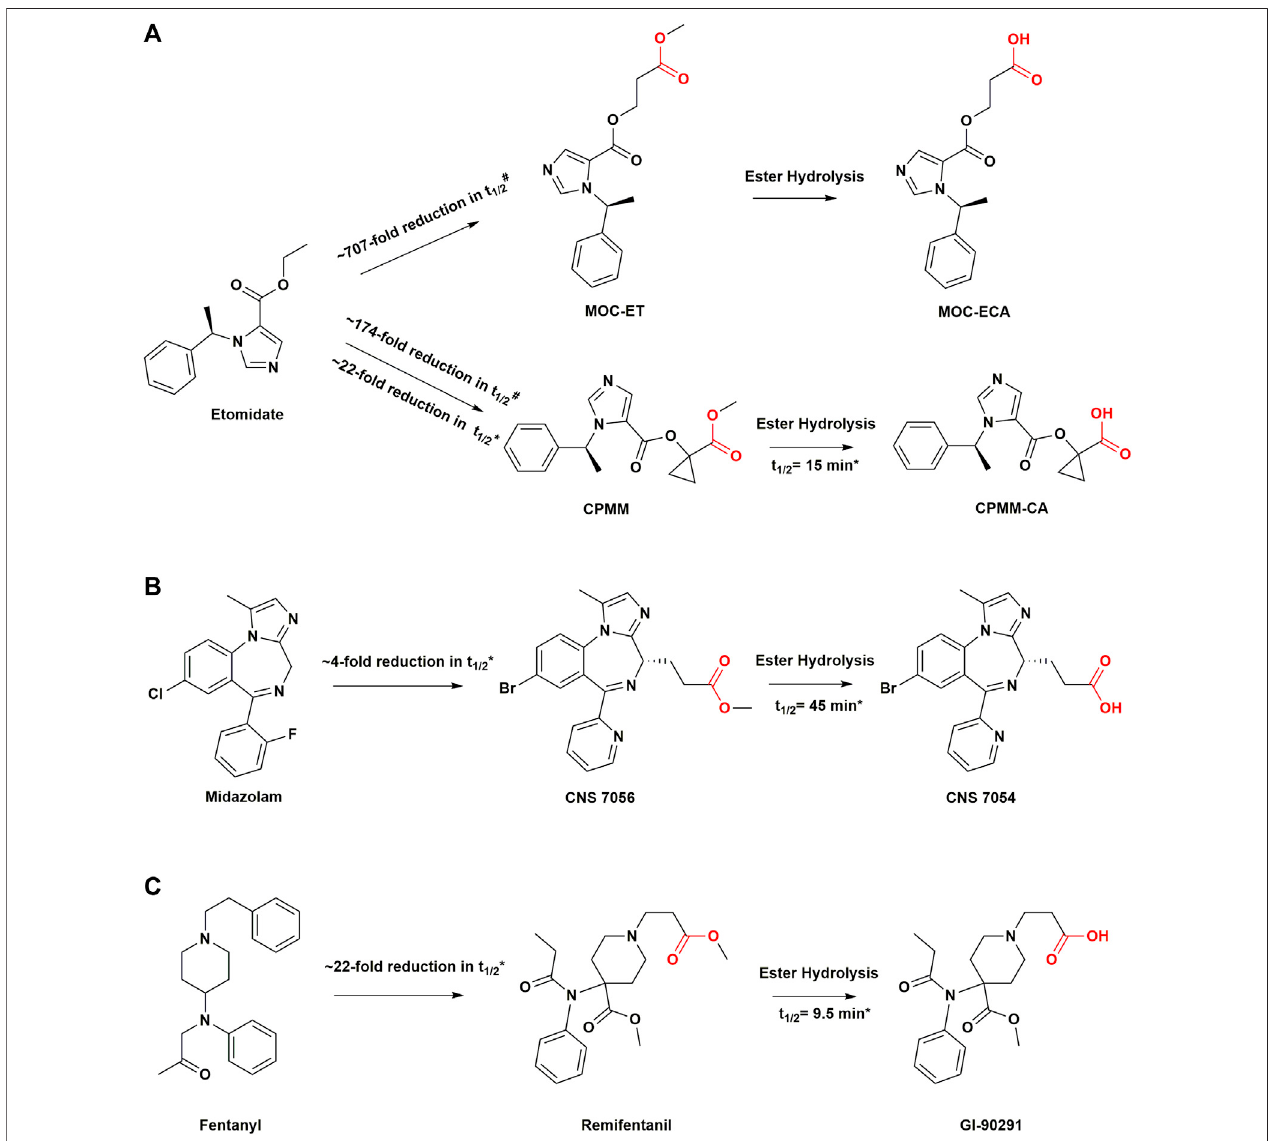
FIGURE 3 | Structural modi fi cations in sedatives and analgesics with soft drug design. (A) Soft analogs of etomidate and their metabolites. (B) Soft analog of midazolam and its metabolite. (C) soft analog of fentanyl and its metabolite. #Values are from measurements of in vitro metabolic half-lives in rat blood. *Values are from measurements of in vivo metabolic half-lives in human body. t 1/2 , half-life; MOC-ET, methoxycarbonyl etomidate; CPMM, cyclopropyl-methoxycarbonyl metomidate.